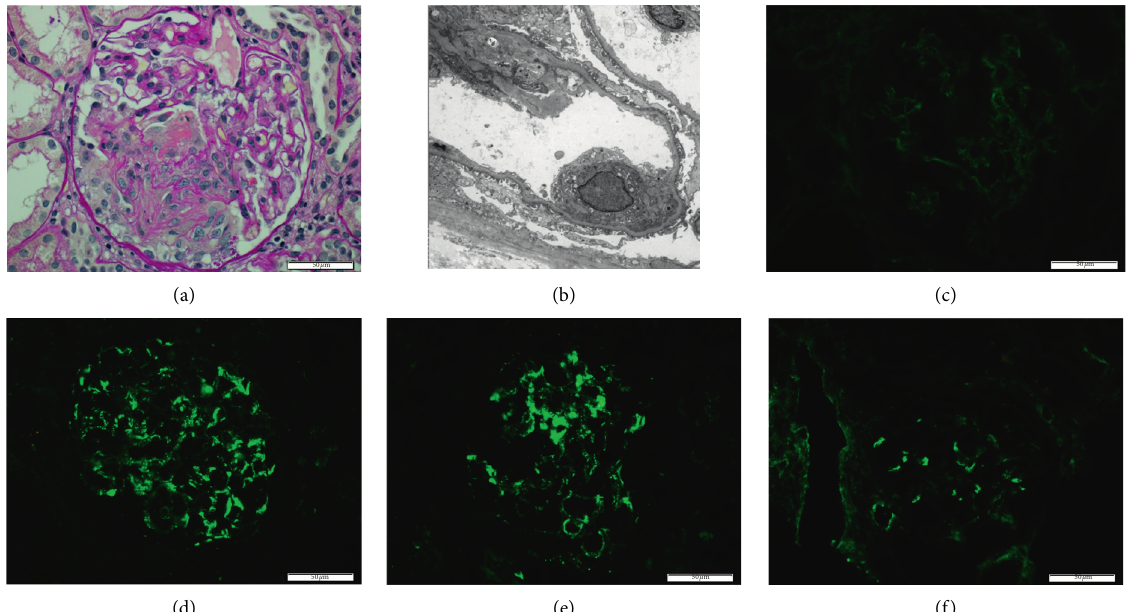
Figure 2: Renal biopsy findings. Eleven of 21 glomeruli presented crescent formation including five cellular crescents and six fibrocellular crescents in light microscope. (a) Renal biopsy revealing necrotizing glomerulonephritis with cellular and fibrocellular crescent formations. No wire loop lesion or nuclear fragmentation is present (hematoxylin-eosin stain). Immunofluorescence staining showing only deposition of IgM and C3c in mesangial areas and peripheral capillaries: (c) IgG, (d) IgM, (e) C3c, and (f) C1q. Electron microscopy showing no electron-dense deposits (b).